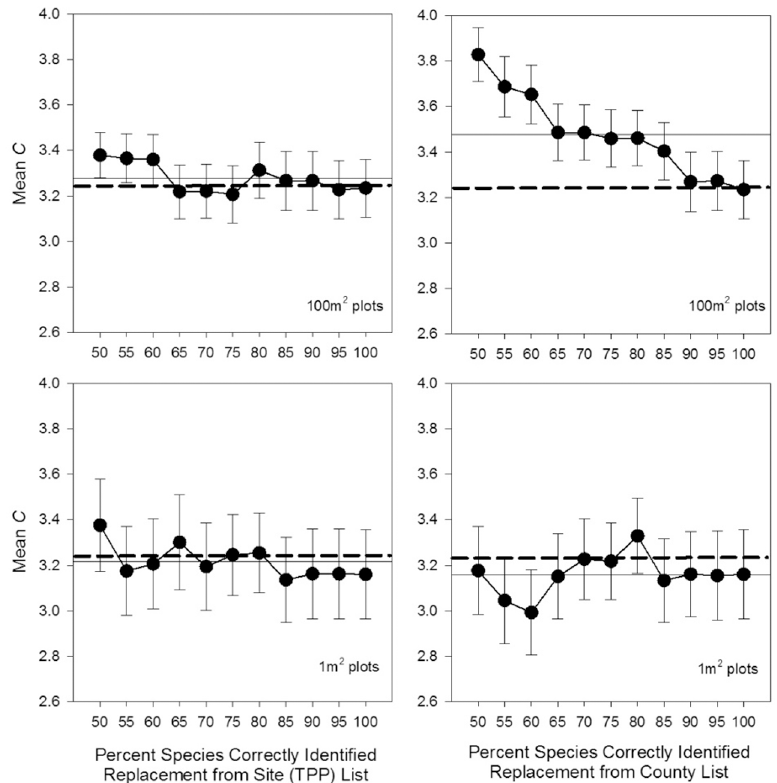
Fig 3. Misidentification Mean C values ( ± 95% CI; N = 20). Species replacement values were obtained from the overall site species list (left), and from the county species list (right). Horizontal lines provide reference levels for comparison. Solid horizontal line indicates average of Mean C points for that plot ’ s size (50 ... 100%), and dashed horizontal line is 100% correct identification value in the 100-m 2 plot.